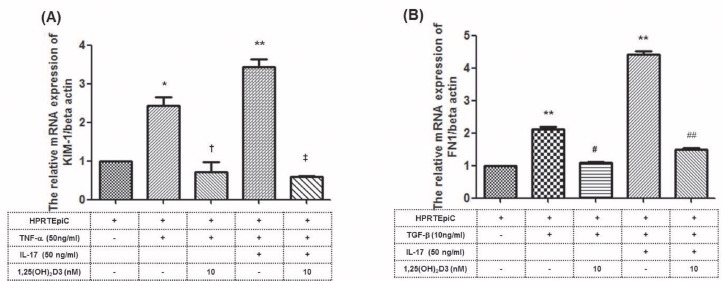
Effect of 1,25(OH)2D3 on the production of KIM-1 and fibronectin 1 from HRPTEpiC induced by recombinant human IL-17 (rhIL-17), human TNF- α or TGF-beta.(A) The expression of KIM-1 by HRPTEpiC was pretreated with 1,25(OH)2D3 (10 nM) as indicated, and then cultured for 24 hours with TNF-α (50 ng/mL) and/or IL-17 (50ng/mL) (n = 3). The expression of KIM-1 was measured by real-time PCR. Note that addition of 1,25(OH)2D3 significantly decrease KIM-1 expression which was increased by TNF-α and IL-17. *P<0.05, **P<0.01 vs. Nill and †P<0.05 vs. TNF- α 50 and ‡P<0.05 vs. TNF-α+IL-17. (B) The expression of Fibronectin-1 by HRPTEpiC was pretreated with 1,25(OH)2D3 (10 nM) as indicated, and then cultured for 24 hours with TGF-β (10 ng/mL) and/or IL-17 (50ng/mL) (n = 3). The expression of fibronectin-1 was measured by real-time PCR. 1,25(OH)2D3 significantly decreased fibronectin-1 expression, which was increased by TGF-β (10 ng/mL) and IL-17. **P<0.01 vs. Nill and #P<0.05 vs. TGF- β 10 and ##P<0.05 vs. TGF- β+IL-17.